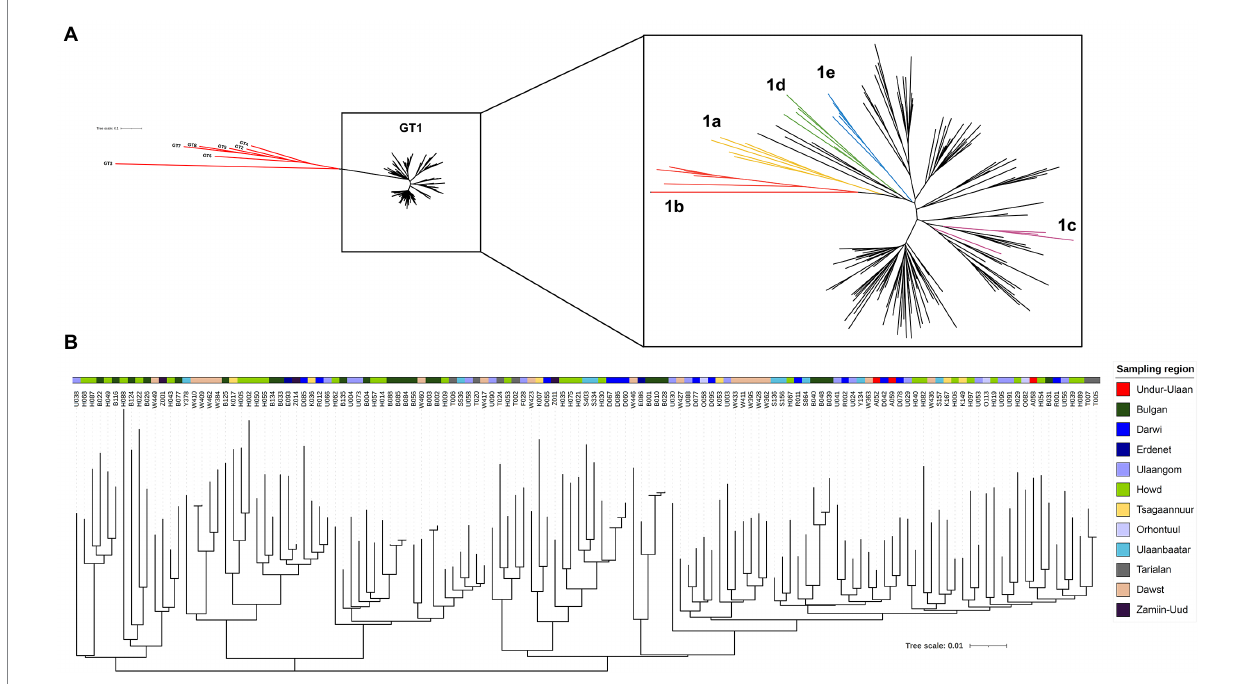
FIGURE 2 Phylogenetic analysis of viral sequences covering the large HDAg. A total of 131 HDV sequences covering the large HDAg were aligned with reference sequences [from (11)] using MAFFT. A phylogenetic tree was calculated with the Mr. Bayes Plugin (34) in Geneious 10.2.8 using the GTR genetic distance model and GT3 as outgroup. (A) Left: unrooted tree all sequences from the HepMongolia cohort together with reference sequences with assigned genotypes. Genotypes 2–8 are colored red, GT1 samples in black. Right: Inset showing only GT1 samples. Sequences from the HepMongolia cohort are colored black, GT1 subtypes described by [(11)] are color coded. (B) Disperse geographical distribution of HDV GT1 subtypes in Mongolia. The color code is according to the sampling